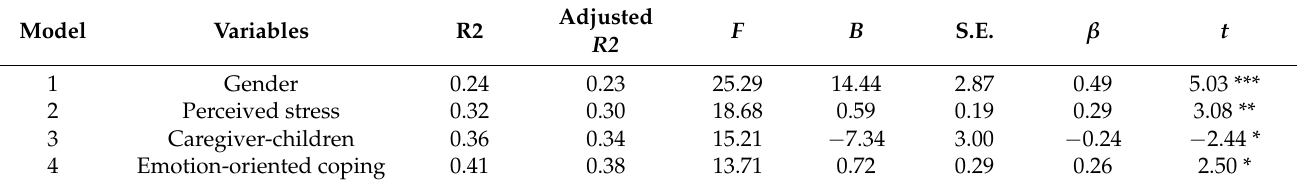
Table 5. Stepwise regression analysis of post-traumatic growth of primary caregivers of liver trans- plant patients ( n =